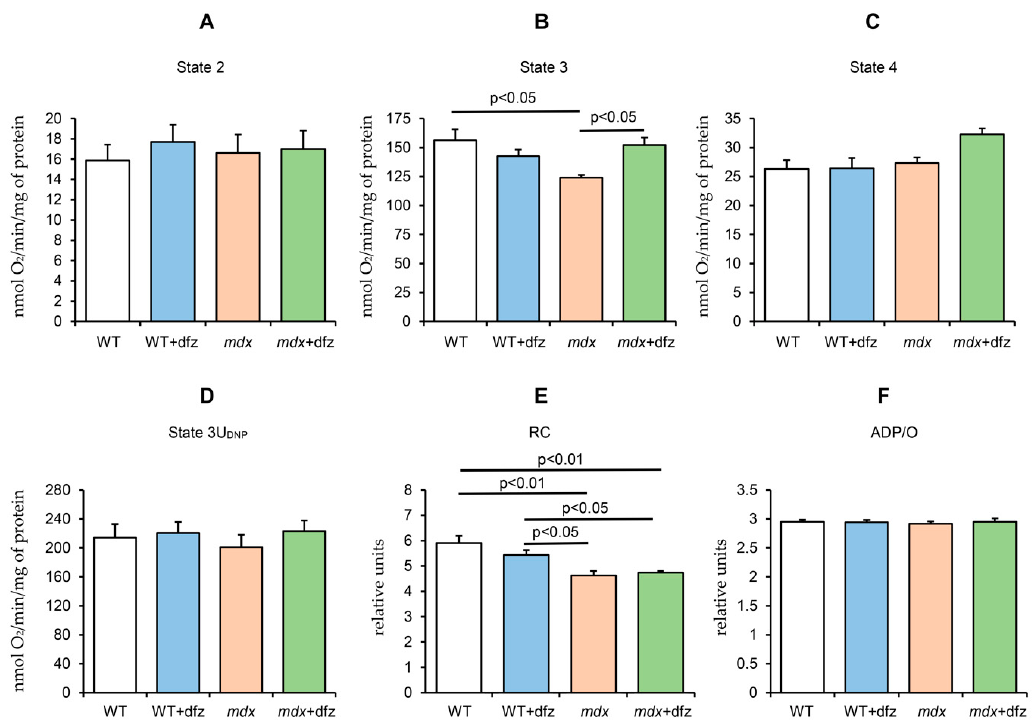
Figure 2. E ff ect of deflazacort administration on glutamate / malate-fueled respiration of skeletal-muscle mitochondria of wild-type and mdx mice in di ff erent functional states ( A – D ) and on the parameters of Figure 2. Effect of deflazacort administration on glutamate/malate-fueled respiration of skeletal- respiratory control ( E ) and ADP / O ( F ). Medium composition: 120 mM KCl, 5 mM NaH 2 PO 4 , and 10 mM muscle mitochondria of wild-type and mdx mice in different functional states ( A – D ) and on the HEPES-KOH bu ff er (pH 7.4) Respiration of mitochondria was fueled by 2.5 mM glutamate + 2.5 mM parameters of respiratory control ( E ) and ADP/O ( F ). Medium composition: 120 mM KCl, 5 mM malate. Respiration of mitochondria in state 3 was initiated by 200 µ M ADP. The rate of uncoupled NaH 2 PO 4 , and 10 mM HEPES-KOH buffer (pH 7.4) Respiration of mitochondria was fueled by 2.5 respiration was measured in the presence of 50 µ M DNP (state 3U DNP ). The data are presented as mM glutamate + 2.5 mM malate. Respiration of mitochondria in state 3 was initiated by 200 μ M ADP. means ± SEM ( n = The rate of uncoupled respiration was measured in the presence of 50 μ M DNP (state 3U DNP ). The data are presented as means ± SEM ( n = 4).